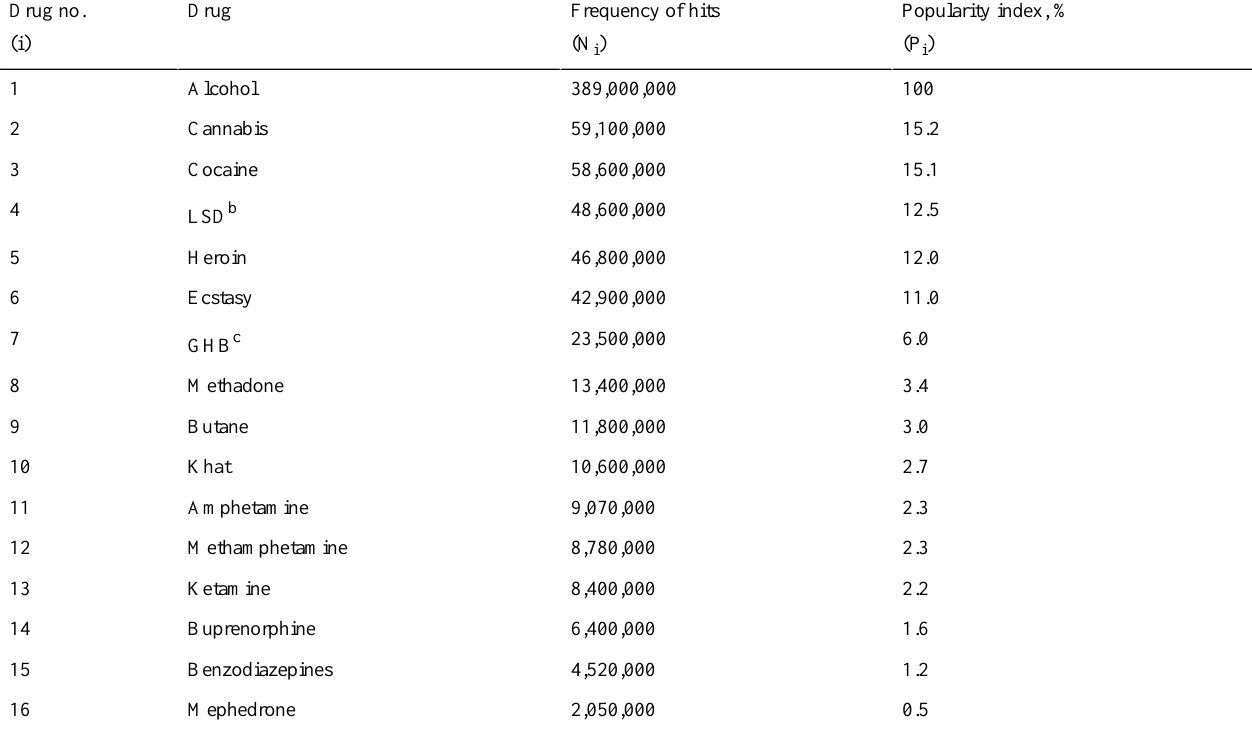
Table 1. Frequency of Google search hits for drugs (N i ) and their relative popularity index (P i ) a , June 20,